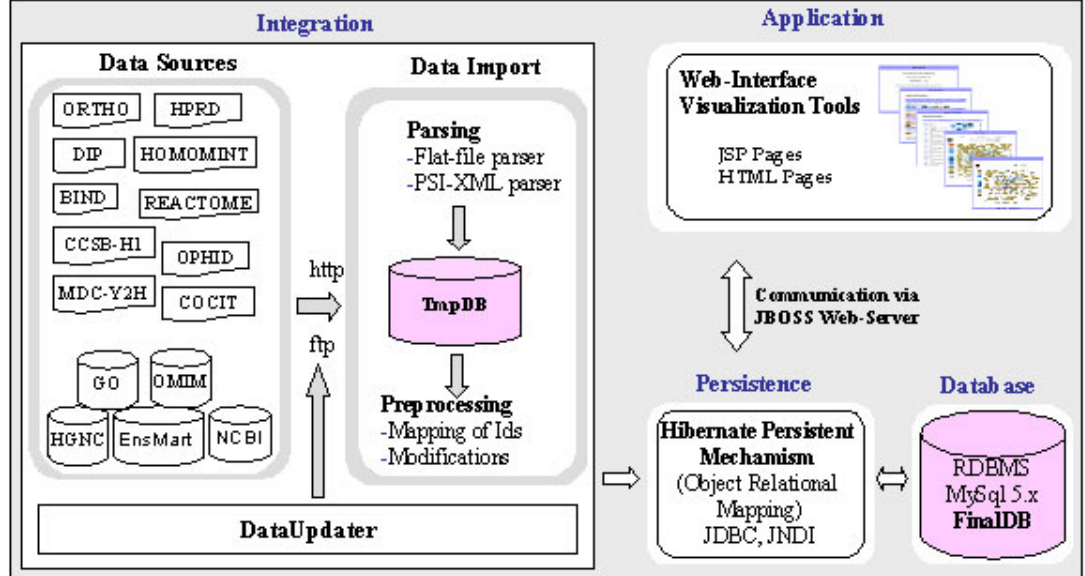
Figure 1: Architecture of the UniHI, consists of four main architectural layers: i) integration, responsible for the data downloading, parsing, preprocessing and updating; ii) database, consists of a relational database which stores and manages the information on proteins and their interaction partners from different sources using one common schema; iii) persistence, used for inserting and retrieving the data from the database via Hibernate persistent mechanism; iv) application, providing a web-interface and a visualization tool for accessing and viewing the interaction